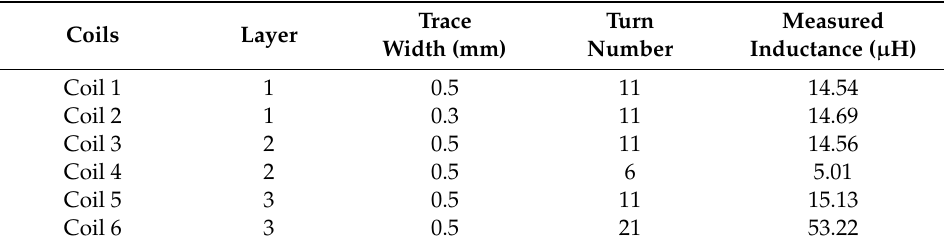
Figure 13. Printed circuit board (PCB) layout of the three ‐ layer hexagonal layout detection coils. Table 1. Detection coil parameters.